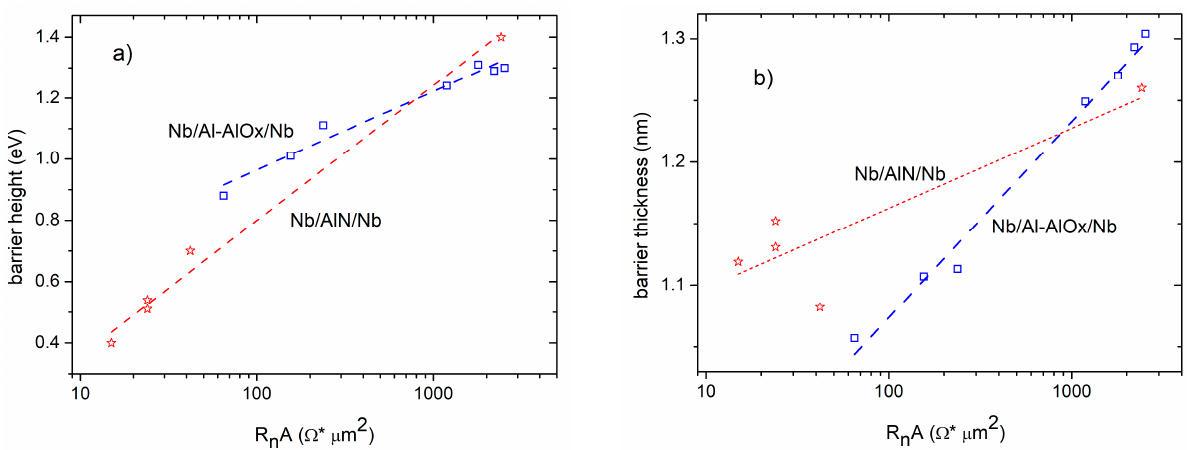
Figure 3. Dependence of the tunnel barrier parameters on resistivity R n A : ( a ) barrier height ϕ ; ( b ) barrier thickness d . Data for the Nb/AlO x /Nb junctions are shown by squares and for the Nb/AlN/Nb junctions by asterisks; the dotted and dashed lines are linear approximations for appropriate data.